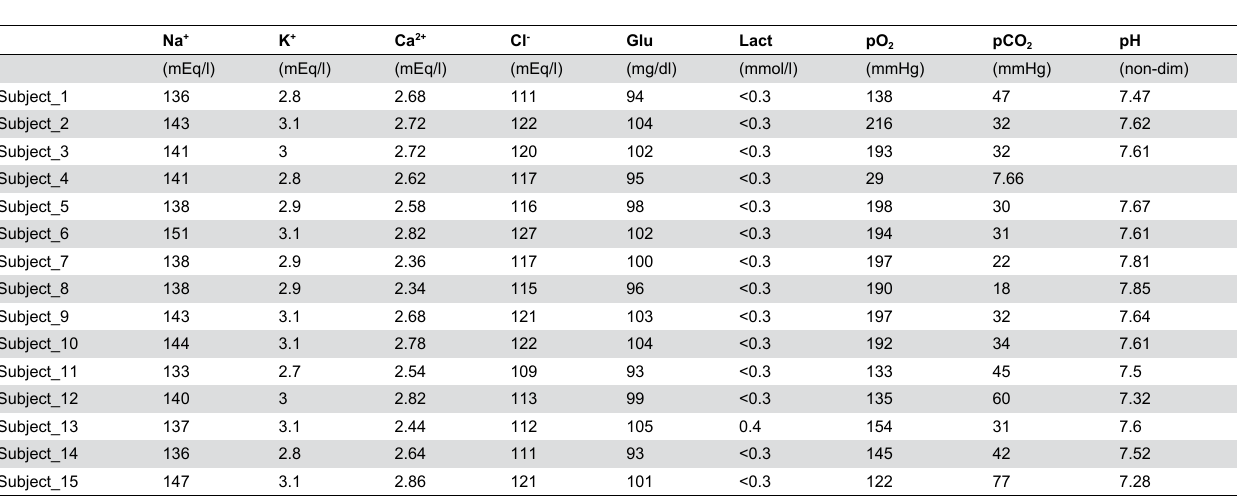
Table 5. Concentration of ions and other variables in dialysate solution samples of fifteen subjects during hemodialysis: sodium (Na + ), potassium (K + ), calcium (Ca 2+ ), chlorine (Cl - ), glucose (Glu), lactate (Lact), oxygen partial pressure (pO carbon dioxide partial pressure (pCO ), 2